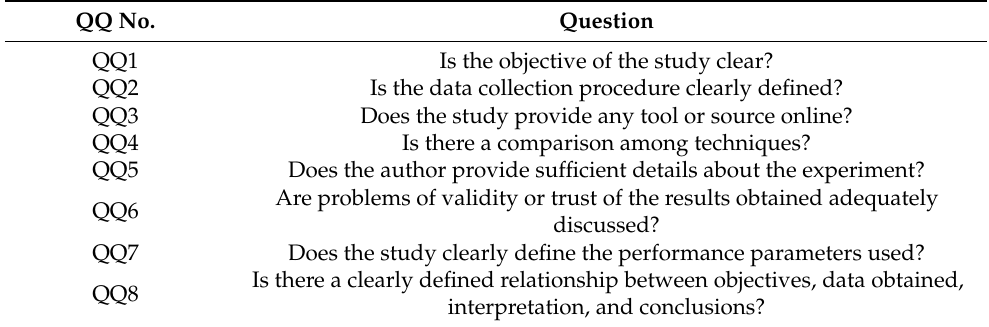
Table 2. Quality assessment questions.